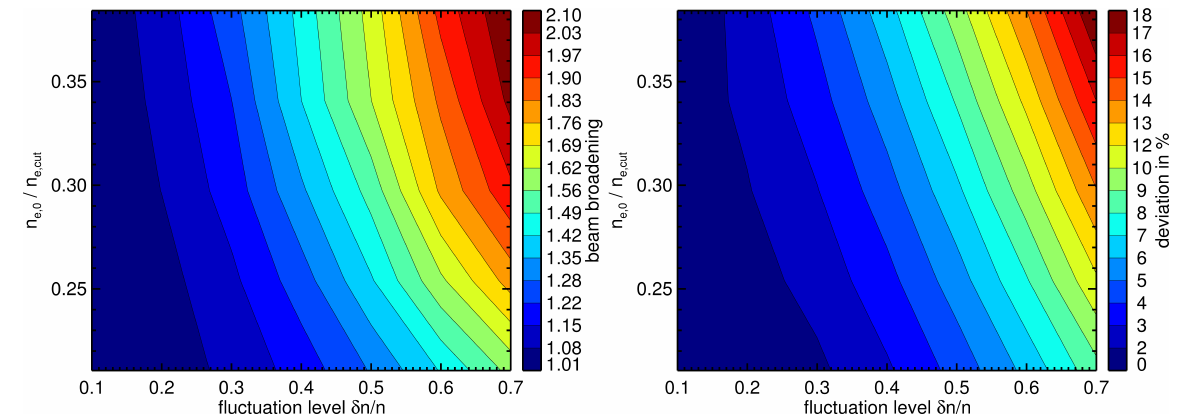
Figure 3. (Left) Beam broadening as obtained from full-wave simulations as a function of the background density at the position of the fluctuation layer and as a function of the fluctuation level. (Right) Overestimation of the corresponding WKBeam results to the full-wave